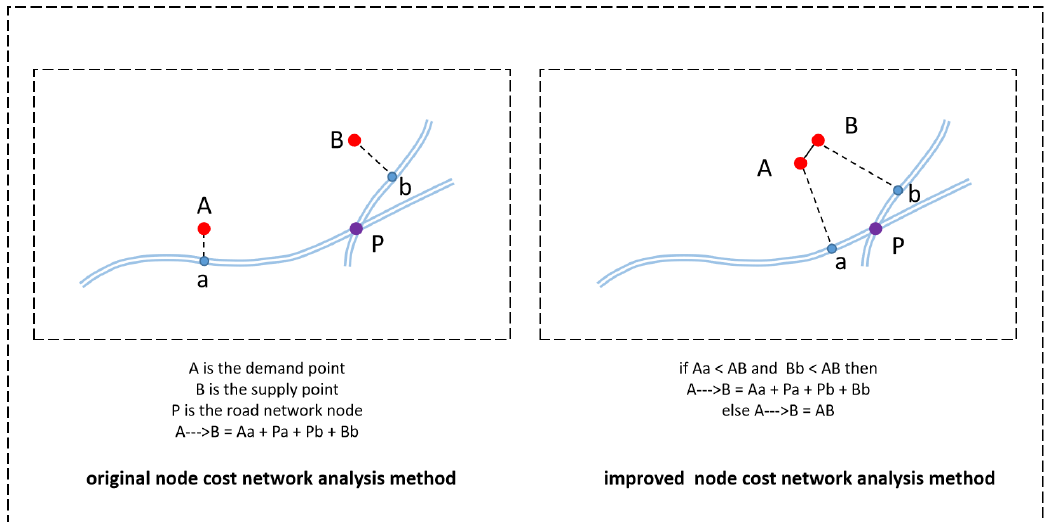
Figure 2. Improved node cost network analysis model diagram.